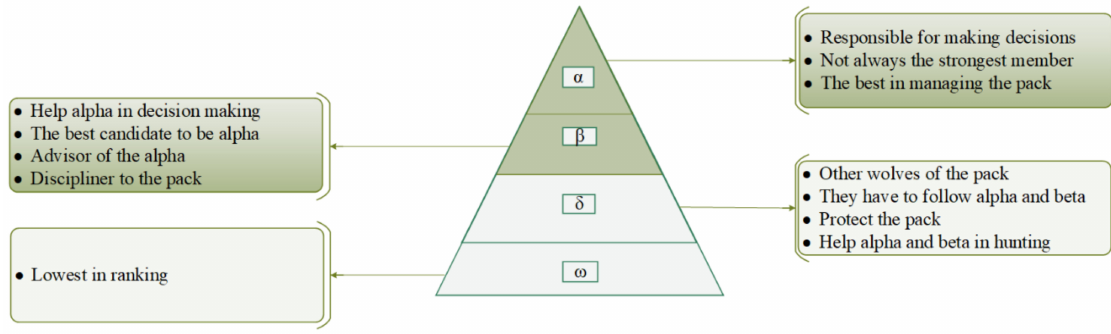
Figure 2. The social hierarchy and responsibilities of the grey